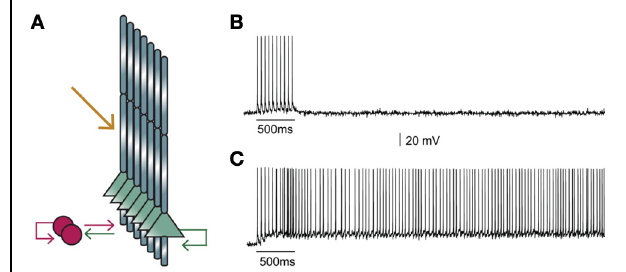
FIGURE 2 | (A) Structure of the microcircuit that includes seven pyramidal and two interneuron models. Green arrows: excitatory connections, red arrows: inhibitory connections. Sustained activity is induced following external stimulation of the proximal apical dendrites (orange arrow). (B) Activation of 90 excitatory synapses impinging on the apical dendrite of each pyramidal neuron model with 10 synchronous events at 20Hz when iNMDA-to-iAMPA ratio is 1.1 and dADP is 0mV does not induce persistent firing. (C) Similar activation conditions as in (B) , but with iNMDA-to-iAMPA ratio = 2.3 and dADP = 0mV, lead to persistent activity. Persistent activity is an all-or-none phenomenon: if induced, it lasts even in the absence of stimulation for the whole duration of the simulation, namely 5s.